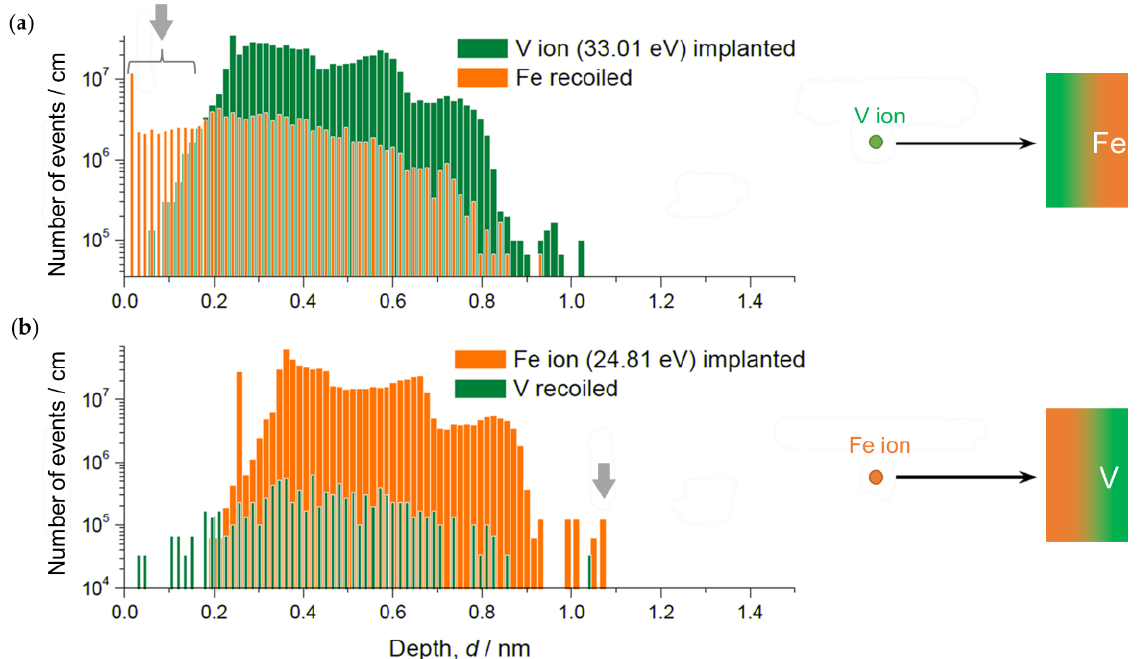
Figure 6. SRIM simulation results of implantation depths and recoil distributions, for V in Fe ( a ) and Fe in V ( b ). Note significant recoil of Fe and deeper penetration depth of Fe than that of V